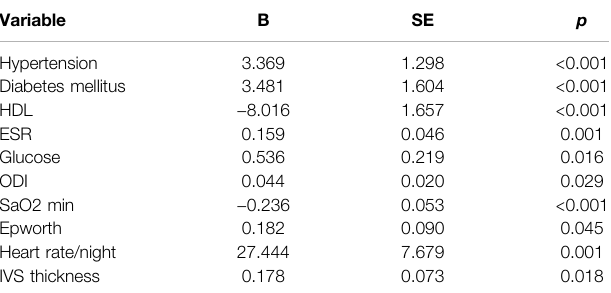
TABLE 7 | Multivariate linear regression model with BMI as a dependent variable.